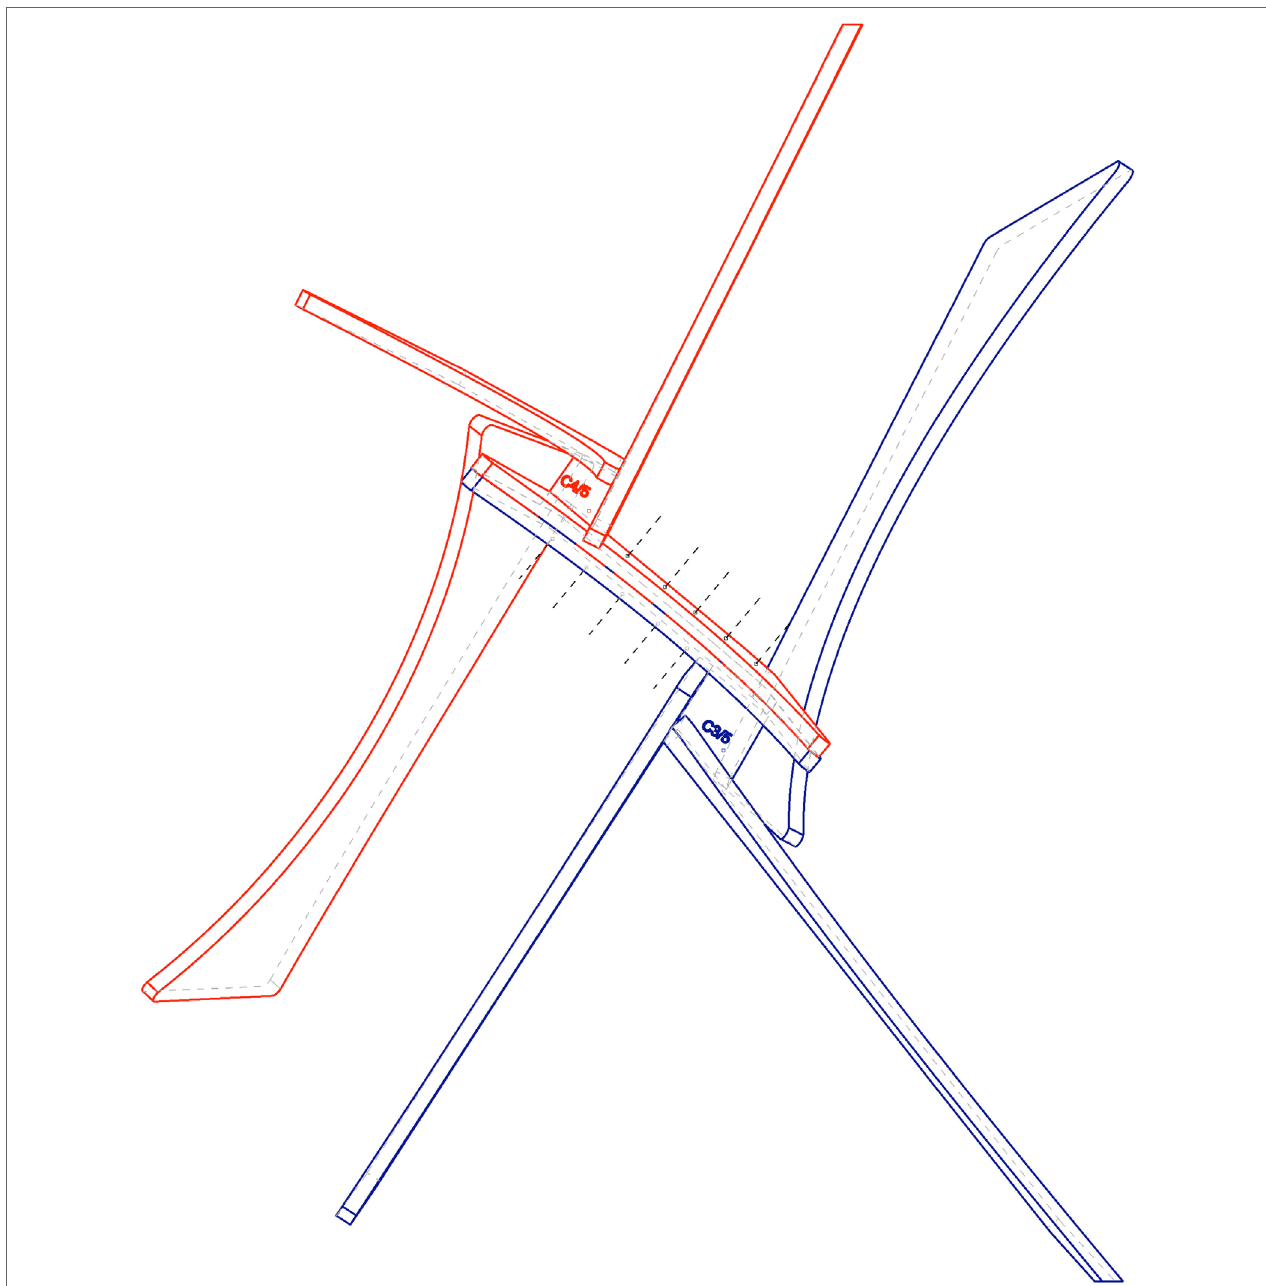
FIgURe 11 | Double-layering principle: overlapping wood sheet between nodes C3/5 and C4/5 with axis of screws connection (five per side).